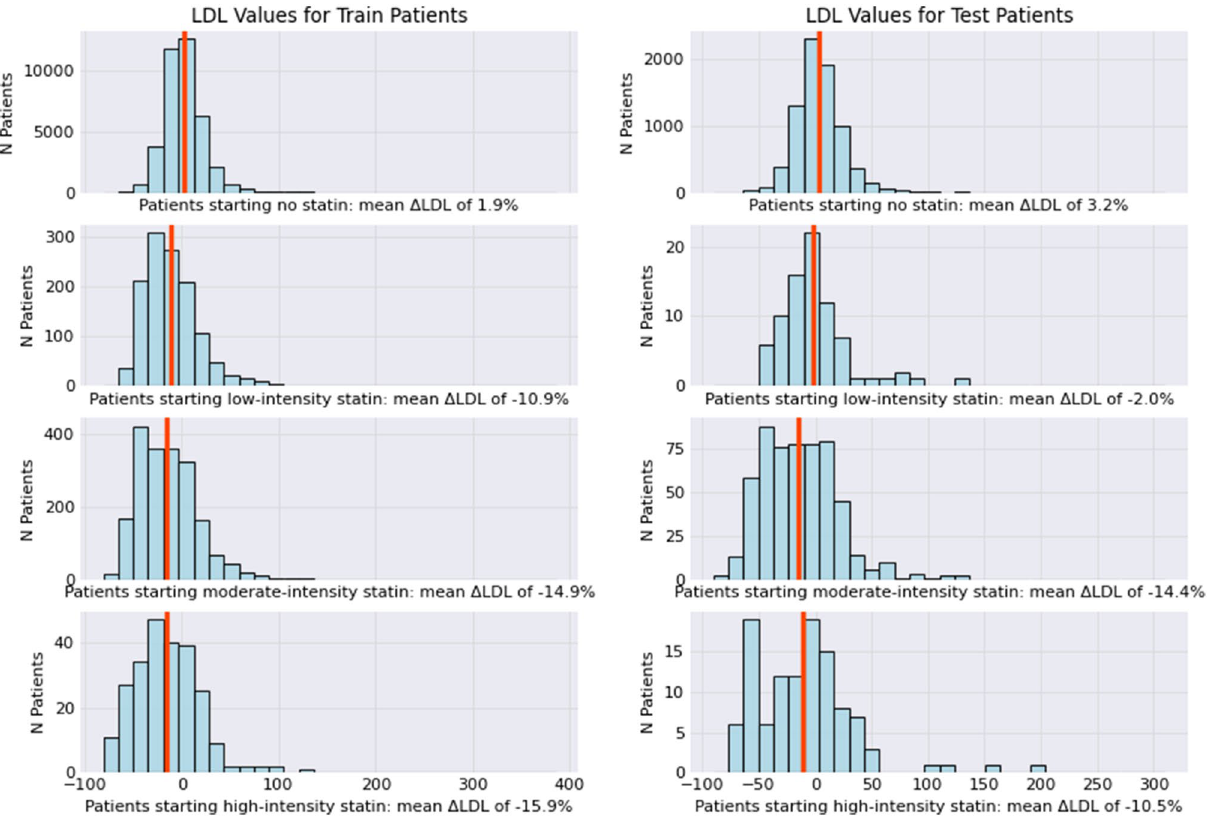
Figure 2. Low density lipoprotein cholesterol responses at 1-year across different statin therapies in the training and test cohorts. LDL-C Low density lipoprotein cholesterol; ΔLDL-C Change in LDL-C (%).